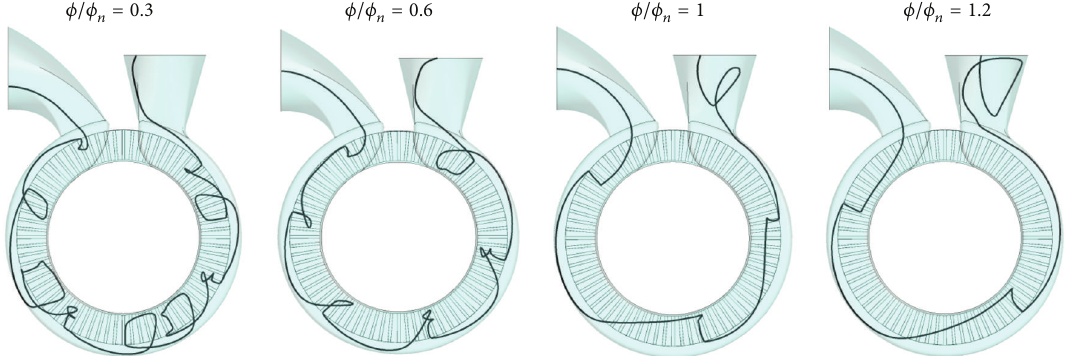
Figure 9: Fluid particle path lines at four different flow coefficients.